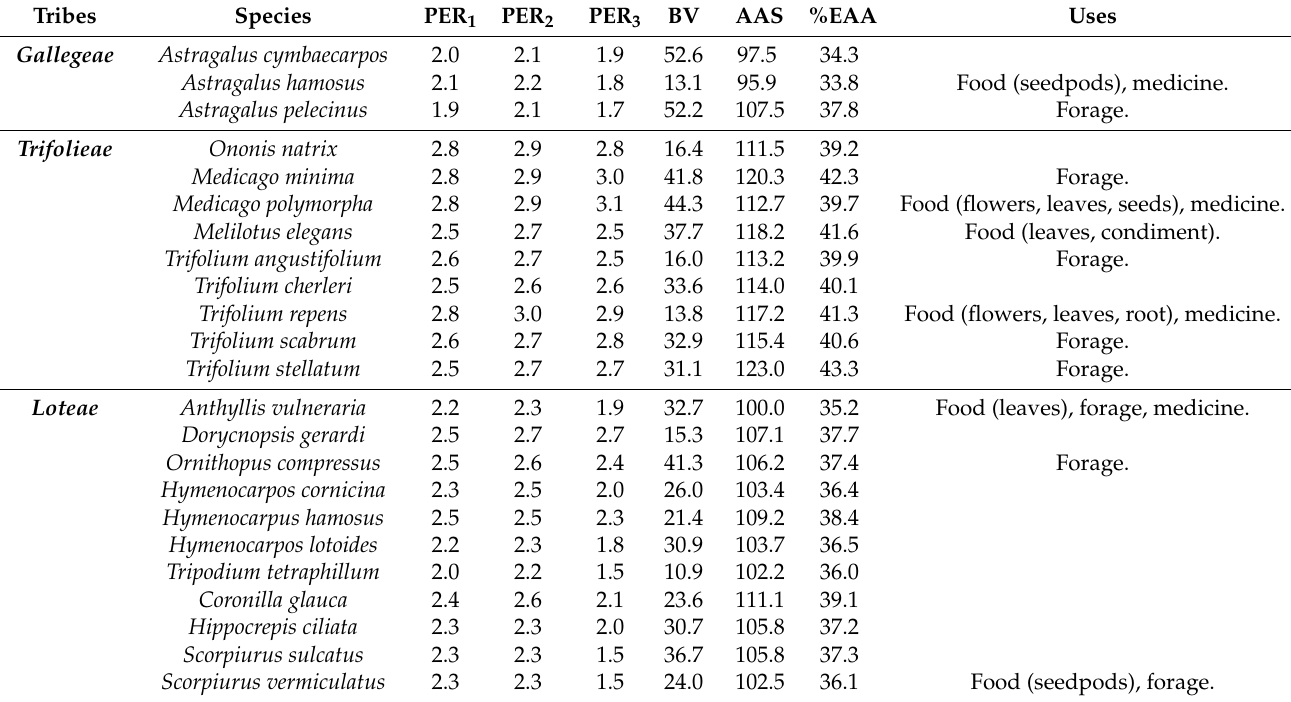
Table 2. Theorethycal nutritional parameters of seed protein based on amino